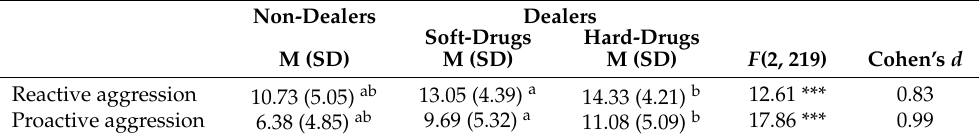
Table 6. Reactive and Proactive Aggression used by Non-Dealers ( N = 79), Soft-Drug Dealers ( N = 63) and Hard-Drug Dealers ( N = 83).